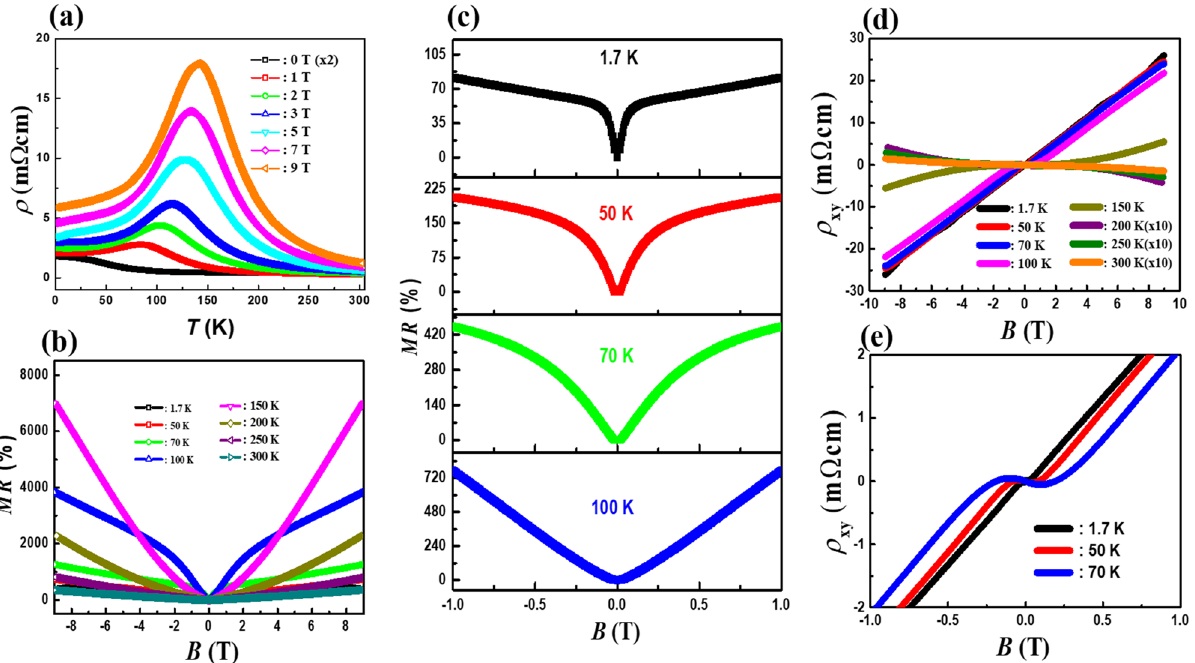
Figure 1. ( a ) Temperature dependences of resistivity ρ in a magnetic field perpendicular to the electric current for the Bi 0.97 Sb 0.03 single crystal. ( b ) Magnetic field dependence of transverse resistivity ρ xx ( B ) of the Bi 0.97 Sb 0.03 single crystal at different temperatures. (c) Enlarge image of transverse resistivity data in low magnetic field at different temperatures ( d ) Hall resistivity ρ xy ( B ) of the Bi 0.97 Sb 0.03 single crystal at various temperatures from 1.7 to 300 K ( e ) Hall resistivity ρ xy ( B ) of the Bi 0.97 Sb 0.03 single crystal at T = 1.7 K, 50 K, and 70